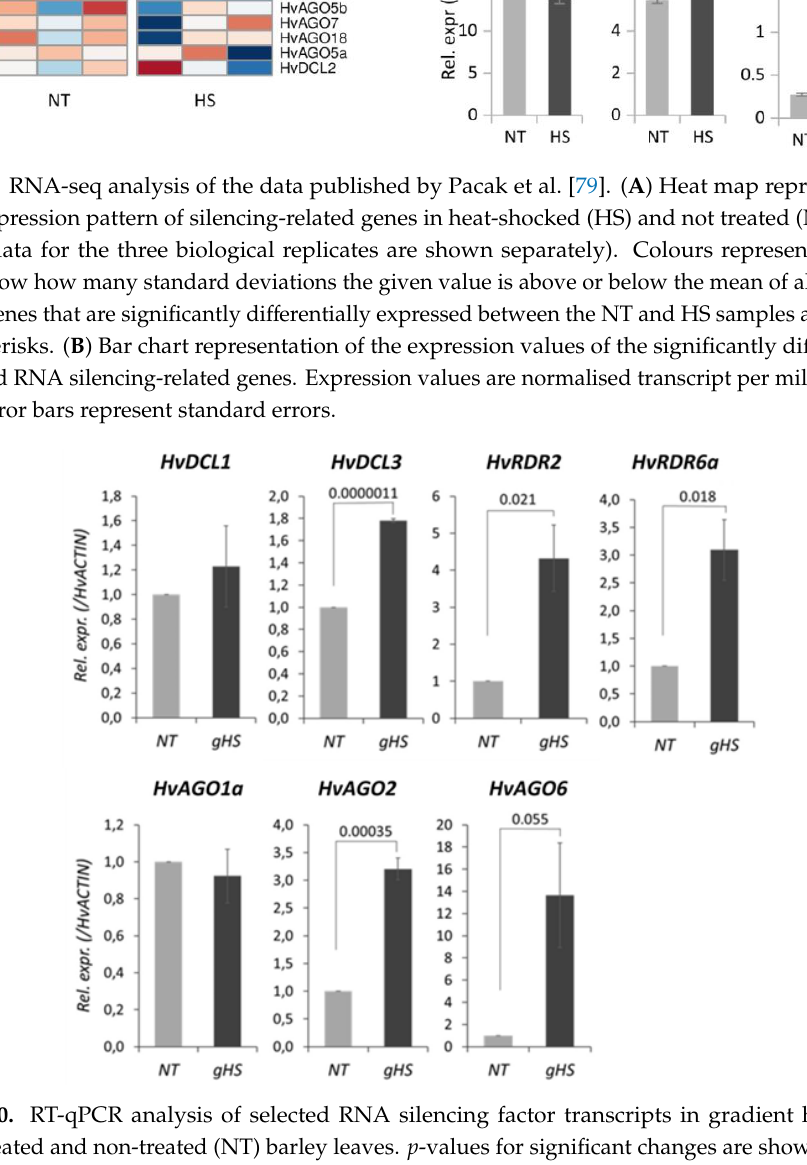
Figure 10. RT-qPCR analysis of selected RNA silencing factor transcripts in gradient heat-shock (gHS)-treated and non-treated (NT) barley leaves. p -values for significant changes are shown over bars. For details, see Materials and the bars. For details, see Materials and Methods.